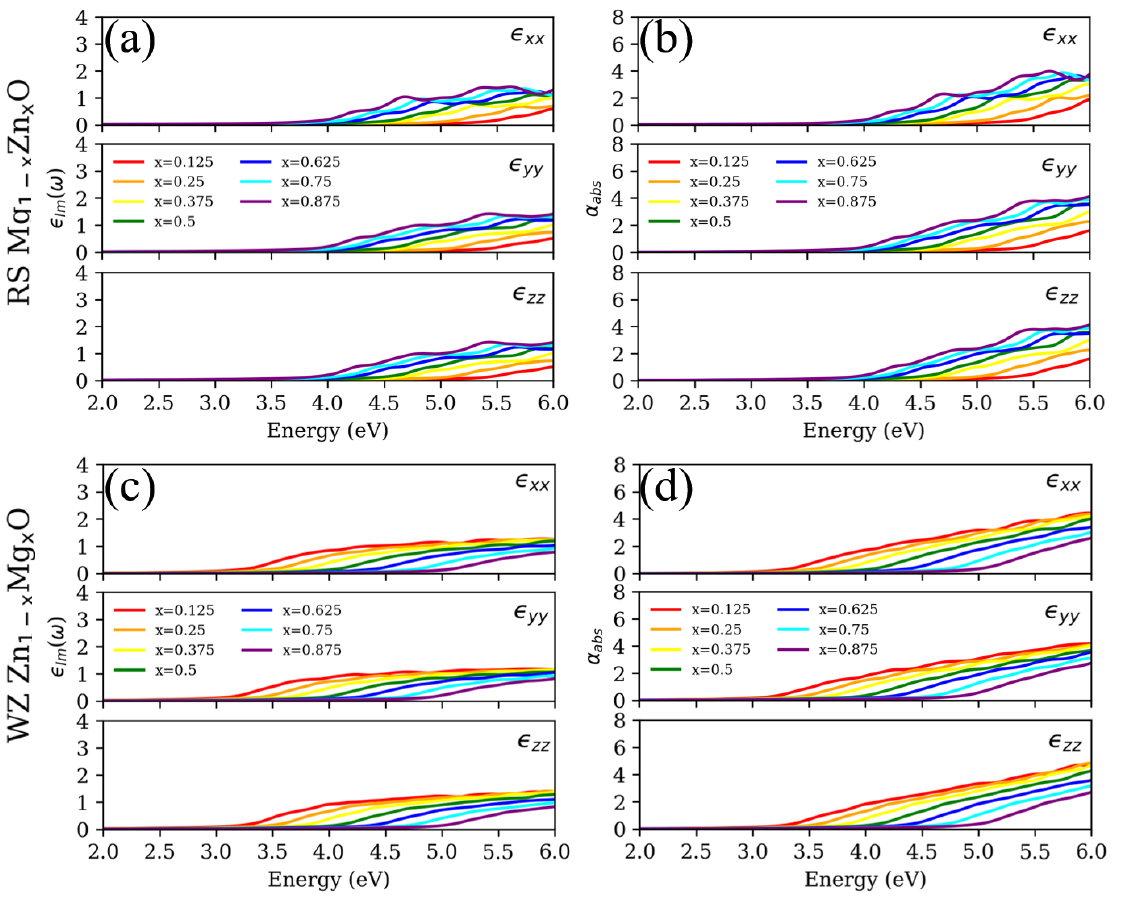
Figure 6. ( a , c ) Imaginary part of the dielectric function ( (cid:101) Im ) and ( b , d ) absorption coefficient ( α abs ) for rocksalt (RS) Mg 1 − x Zn x O and wurtzite (WZ) Zn 1 − x Mg x O based on linear response theory within RPA. The first rows ( a , b ) demonstrate the RS phases; the second rows ( c , d ) represent the WZ phases. The top, middle and bottom panel for each sub-figures correspond to the direction of (cid:101) xx , (cid:101) yy and (cid:101) zz , respectively. The red, orange, yellow, green, blue, cyan and purple lines individually correspond to the concentrations (x) of 0.125, 0.25, 0.375, 0.5, 0.625, 0.75 and